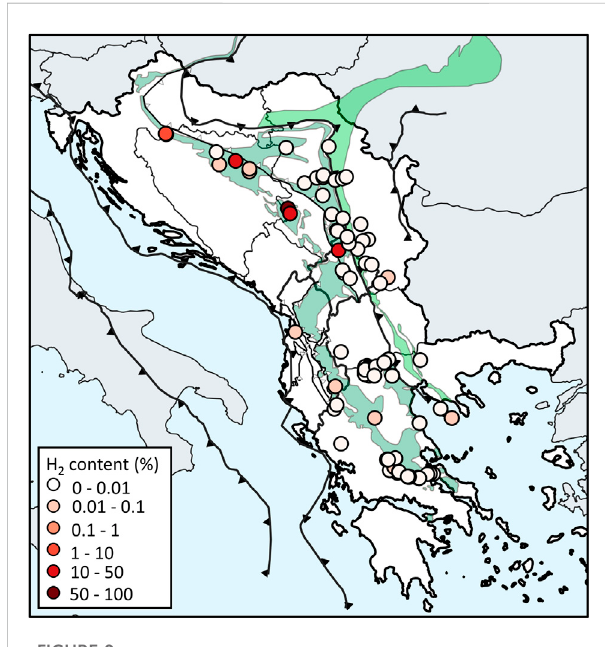
FIGURE 9 Compilation of the H 2 content in gas seeps in the Dinarides from this study and others in the literature (Minissale et al., 1989; Daskalopoulou, 2017; Etiope et al., 2017; Randazzo et al.,